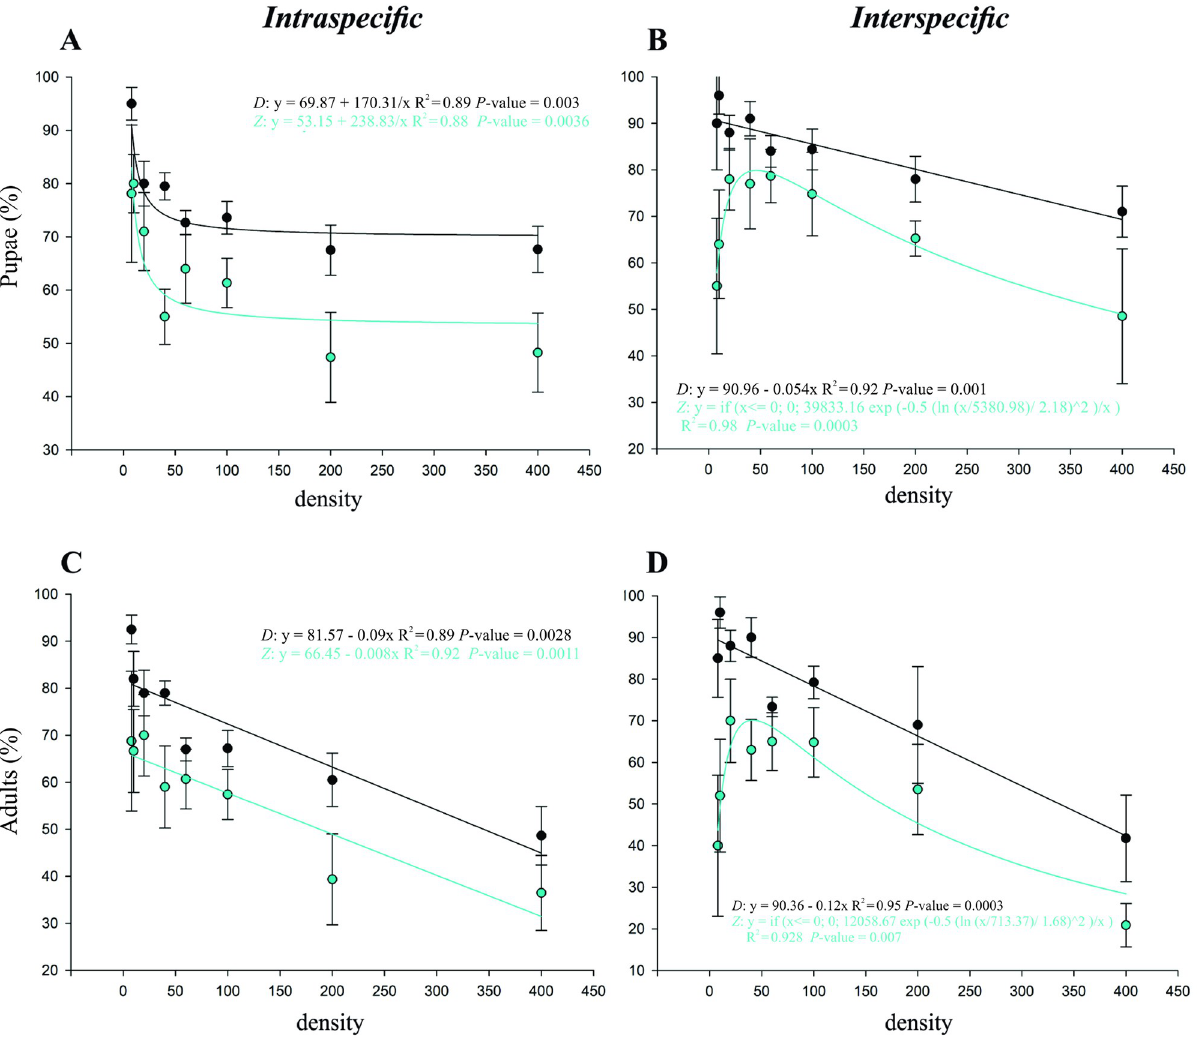
Fig 2. Development bioassay. Percentages of egg-pupa and pupa-adult viability of Drosophila suzukii (D) and Zaprionus indianus (Z) fitted to regression functions at eight intra- and interspecific egg densities, ranging from 8 to 400. (A) Egg-pupa intraspecific survival. (B) Egg-pupa interspecific survival. (C) Intraspecific emergence percentage of adults. (D) Interspecific emergence of adults.